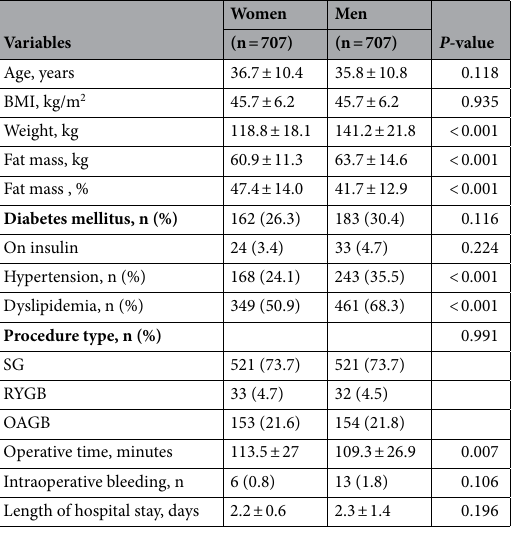
Table 2. Preoperative and operative data of men and women matched for age, preoperative BMI and the type of procedure. BMI, body mass index; SG, sleeve gastrectomy; RYGB, roux-en-y gastric bypass; OAGB, one- anastomosis gastric bypass. Continuous and categorical variables are represented as mean ± SD and frequency (percentage), respectively.